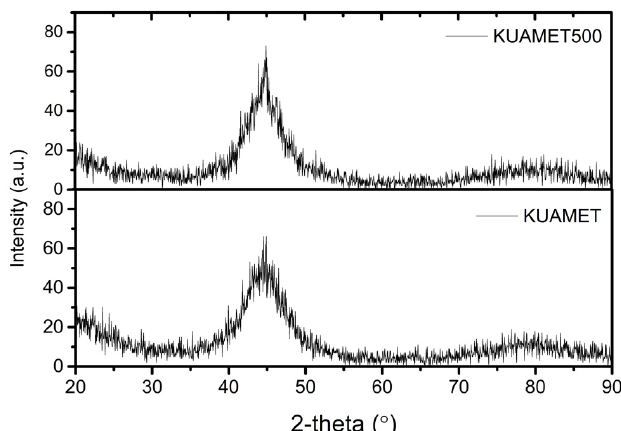
Figure 3. XRD patterns of the amorphous FeSiCrB alloy powders before (KUAMET) and after heat treatment (KUAMET 500).